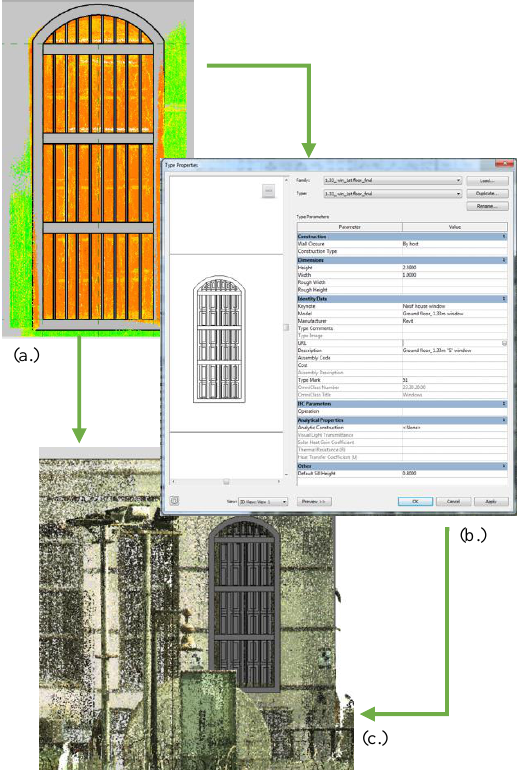
Figure 7: Modelling the window as a Revit family block to be inserted into the Nasif house project. (a.) Modelling the object based on point cloud. (b.) The properties of the object. (c.) Placing the object into the